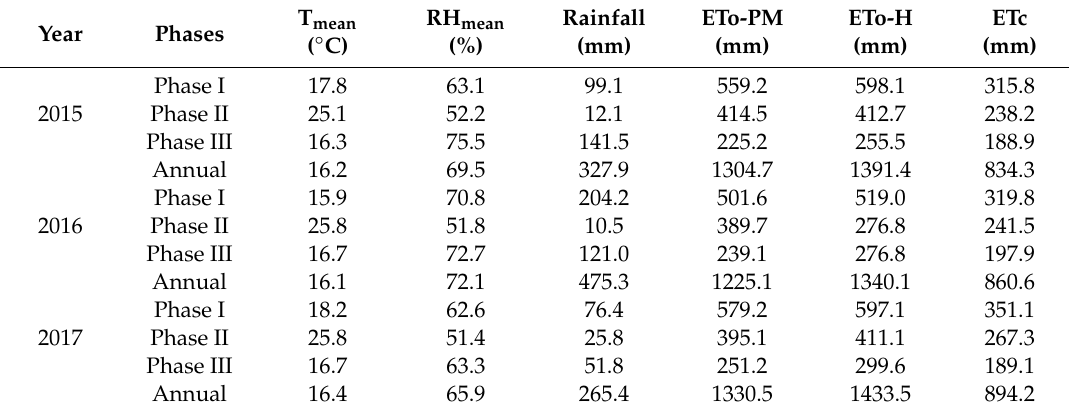
Table 3. Mean temperature (T mean ), mean relative humidity (RH mean ), cumulative rainfall and cumulative evapotranspiration (ETo) and crop evapotranspiration (ETc) for each year and each phase of the crop